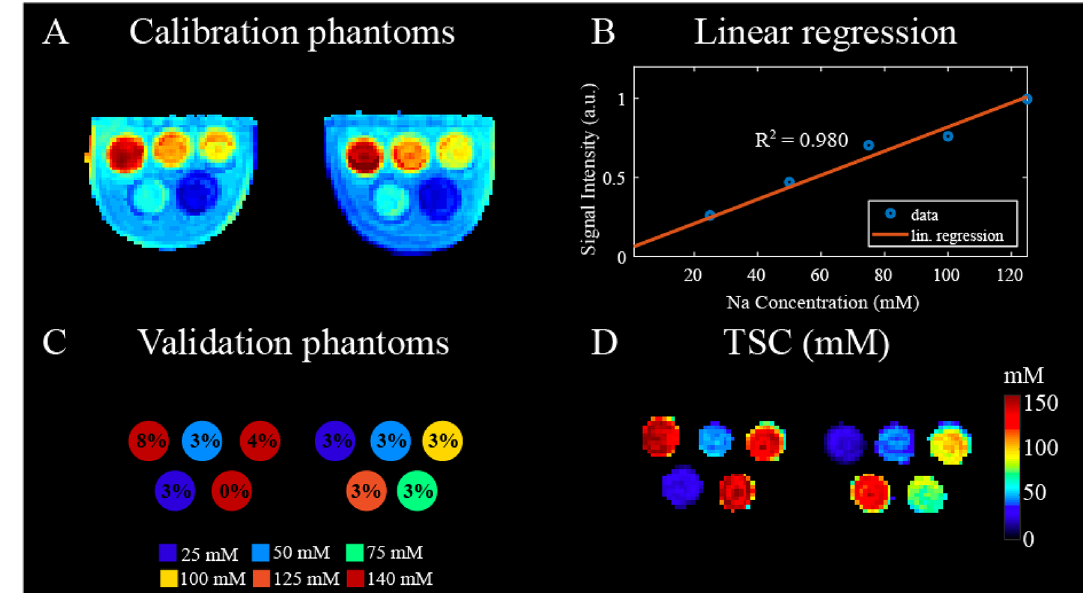
Figure 3. Total sodium concentration (TSC) calibration and validation in phantoms. ( A ) Calibration phantoms with ten 3% agar gels with sodium concentration ranging from 25 to 125 mM with 25 mM step. The FLORET dataset was corrected to account for B 1 profile and gels relaxation times. ( B ) Calibration curve, R 2 = 0.980. Each point in the plot corresponds to the average signal intensity of two bilateral gels with same sodium concentration. ( C ) Schematic of validation phantoms consisting of ten gels with agar concentrations between 0 and 8%, which are overlaid for each gel. The true sodium concentrations are color coded and ranged between 25 and 140 mM. ( D ) TSC map (mM) measured in validation phantoms shows good agreement with ground truth with < 7% error. Specifically, the mean TSC calculated in the 0%, 4% and 8% agar gels (true concentration: 140 mM) were, respectively, 141.9 ± 18.4 mM, 137.9 ± 9.7 mM and 150.0 ± 12.0 mM. In the 3% agar gels (true concentrations: 25, 50, 75, 100, 125 mM) the mean TSC were: 26.5 ± 2.9 mM, 47.3 ± 3.8 mM, 78.3 ± 6.3 mM, 95.5 ± 7.6 mM and 125.4 ± 10.0 mM. The relaxation times of the 0%, 3%, 4% and 8% agar gels are reported in Supplementary Table S1.